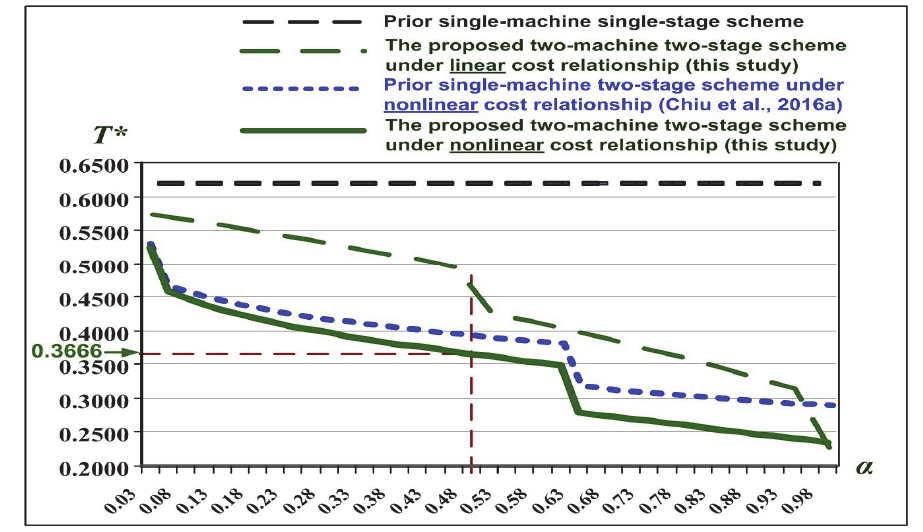
Fig. 10. Variations in α on T* for both single- and two-machine fabrication schemes under both linear and nonlinear